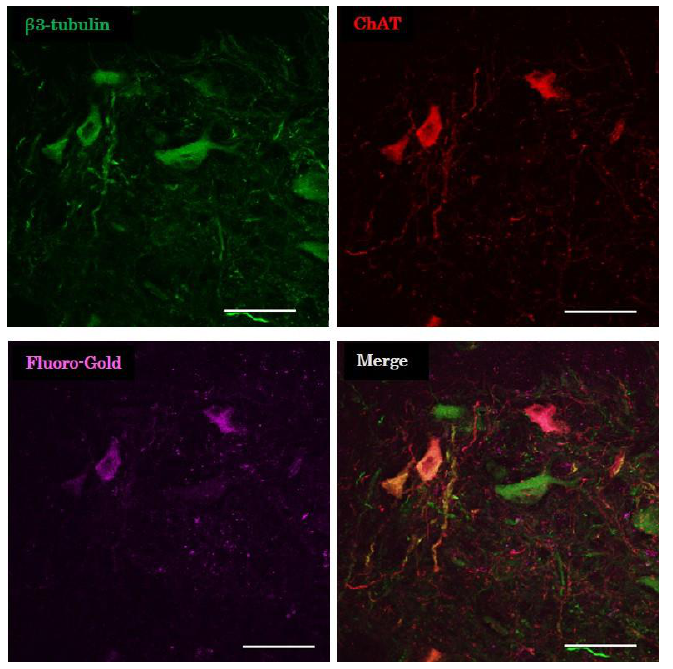
Figure 5. Evaluation of the neuromuscular junction after immunohistochemistry. ( a ) Microscopic image of extensor hallucis longus in the E 27 group. ( b ) Microscopic image of extensor hallucis lon- gus in the surgical control group. Scale bar = 50 µm.